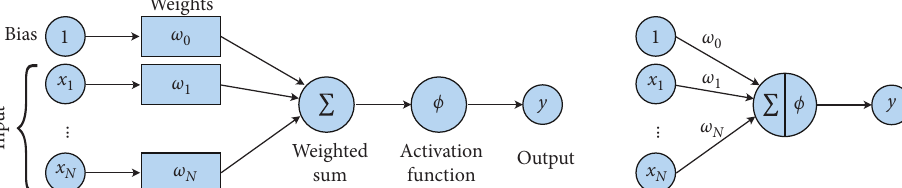
Figure 7: Graphical representation of a single neuron/perceptron used to construct neural networks. The neuron consists of N + 1 weights together with a so-called activation function that is applied to the weighted sum of the inputs. The left figure shows the perceptron in a detailed diagram, while the right representation is usually used if the perceptron is part of a neural network. Hereby, the weighted sum is combined with the application of the activation function in one circle.